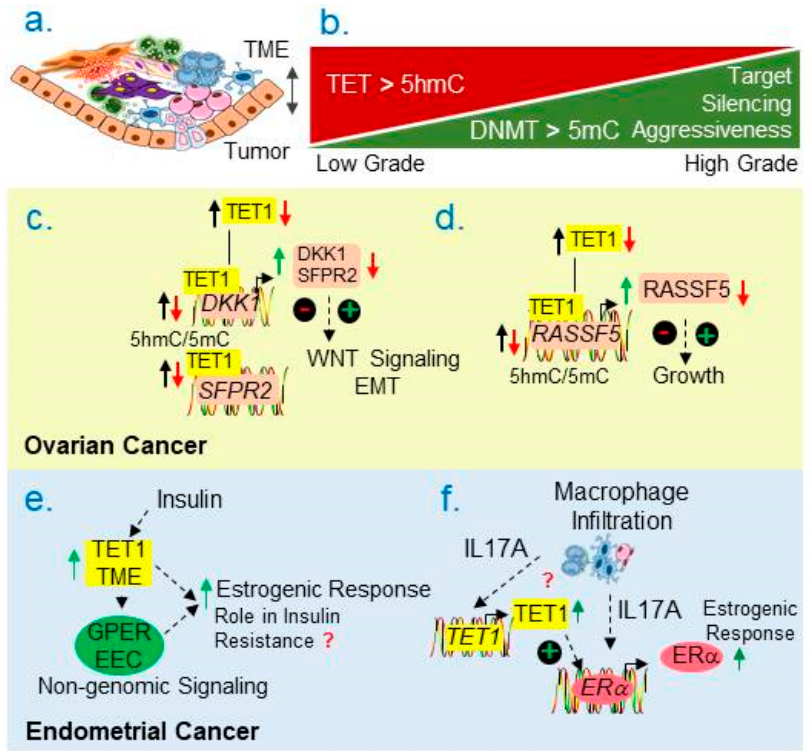
Figure 6. DNA 5mC status and cancer aggressiveness. ( a ) Illustrations showing the tumor and tumor microenvironment interactions (TME). See Supplementary Figure S1 for description of TME. ( b ) Reduced levels of TETs and 5hmC and increased levels of DNMT and 5mC in aggressive ovarian and endometrial cancers. ( c ) TET regulation of WNT signaling via controlling the transcription of negative regulators DKK and SFPR2. ( d ) TET1 regulation of ovarian cancer growth via tumor suppressor RASSF5 expression. ( e ) Insulin stimulation of TET1 expression in TME cells and upregulation of non-genomic GPER signaling in endometrial cancer cells. ( f ) Macrophage infiltration linked released of IL17A cytokine in re-expression of ER in endometrial cancer cells via modulating the level of TET1 expression.